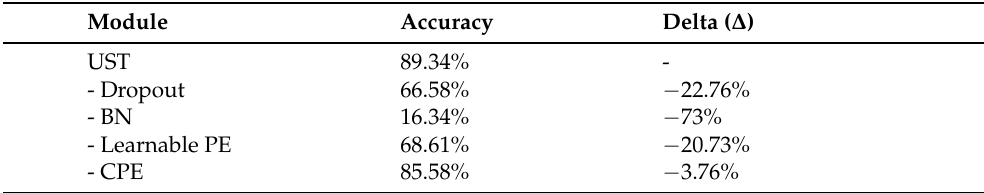
Table 10. Ablation analysis of the model structure.